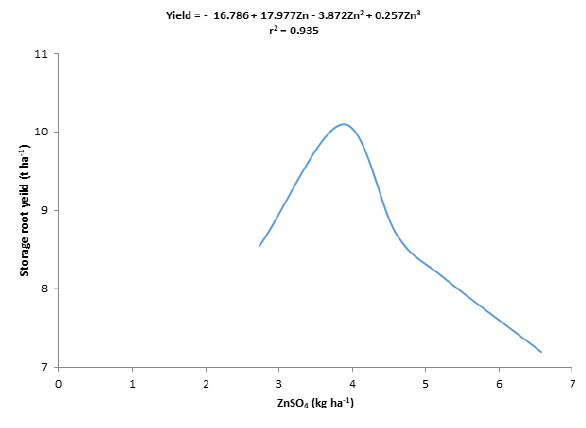
was described by a cubic model with an r 2 = 0.935. The optimum ZnSO fertilizer for maximum sweet potato yield 4 was obtained at 3.9 kg ha -1 ZnSO fertilizer. 4